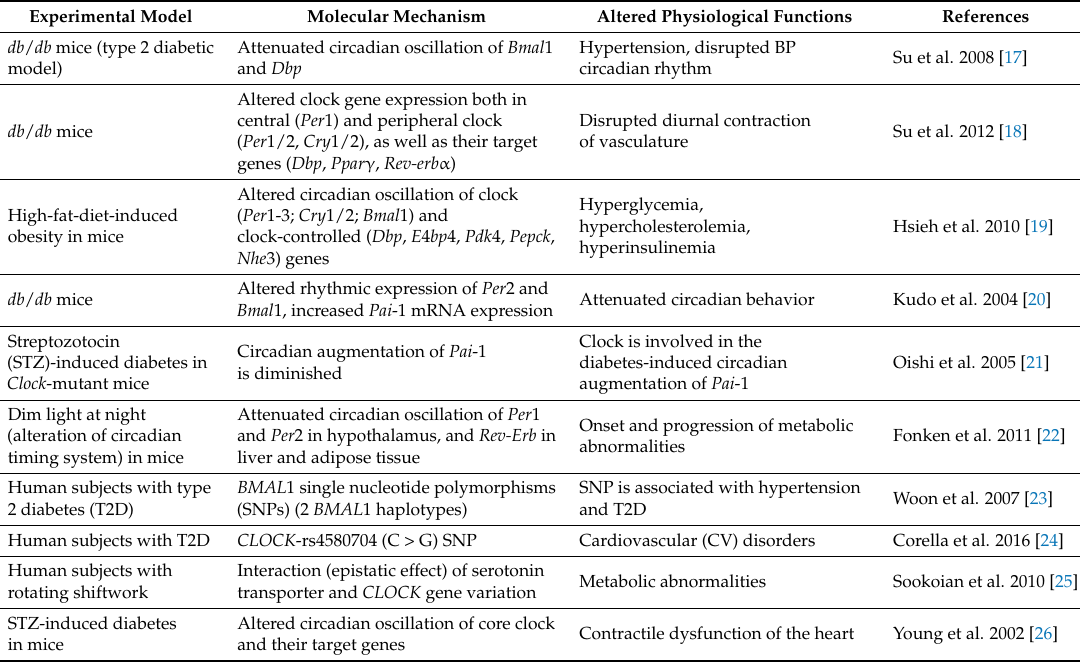
Table 1. Altered expression profiles of molecular components of the circadian timing system in subjects with metabolic dysfunction that are directly or indirectly associated with a disrupted dipping pattern of